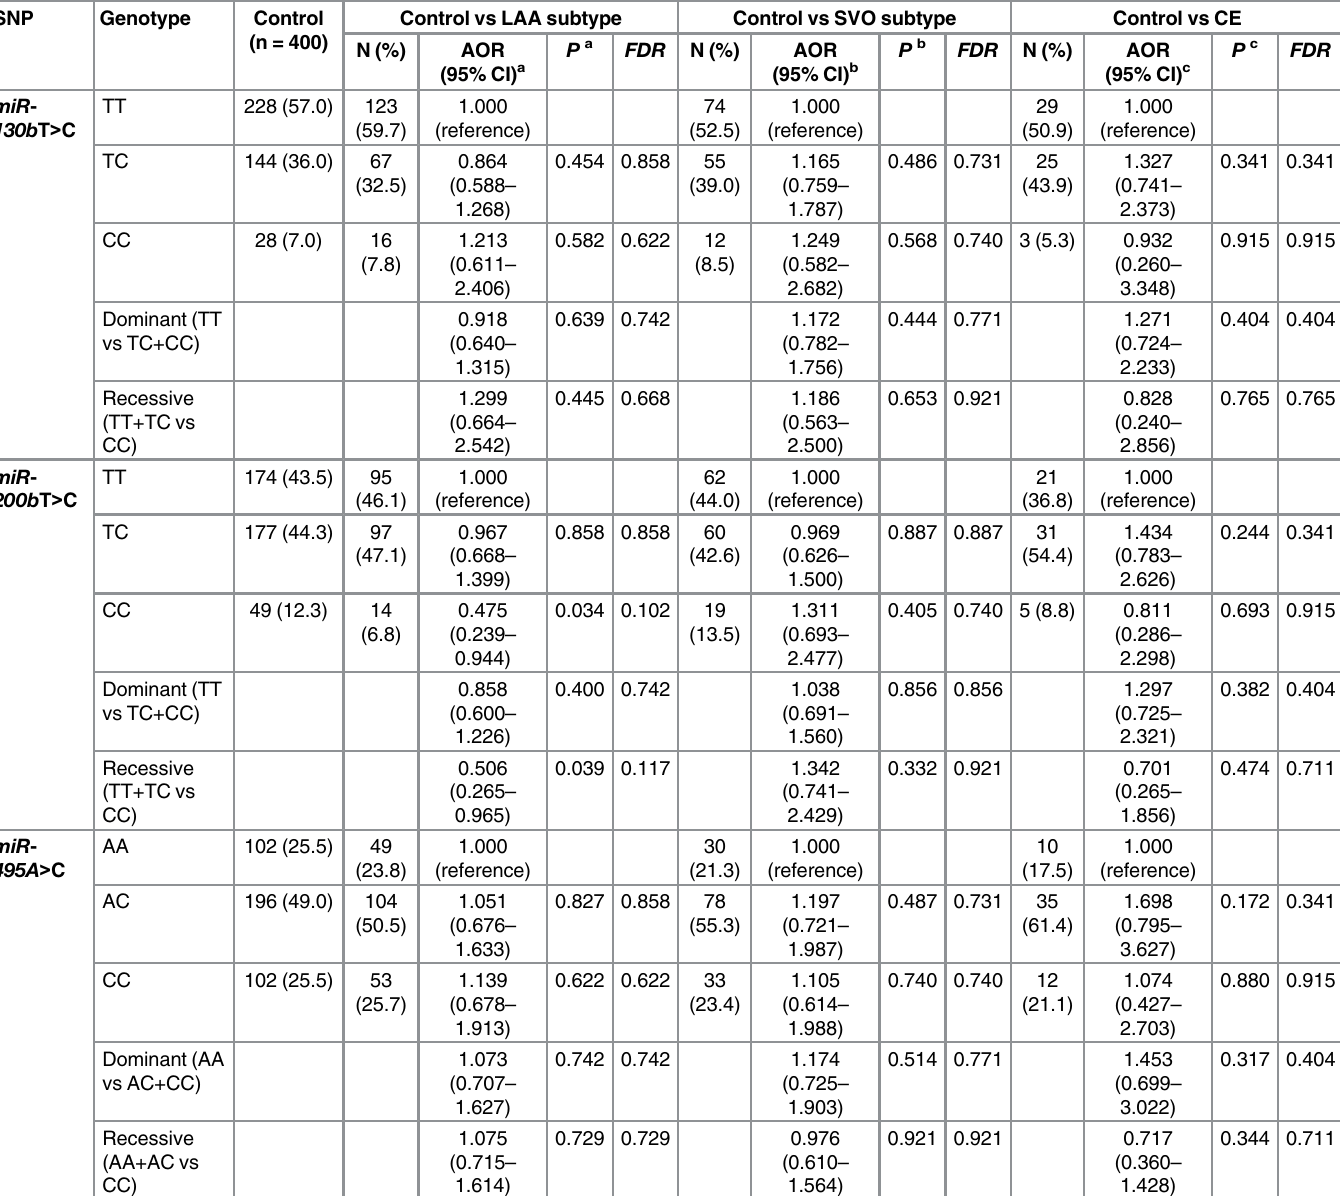
Table 3. Comparison of genotype frequencies of microRNA polymorphisms between ischemic stroke subtype and control.